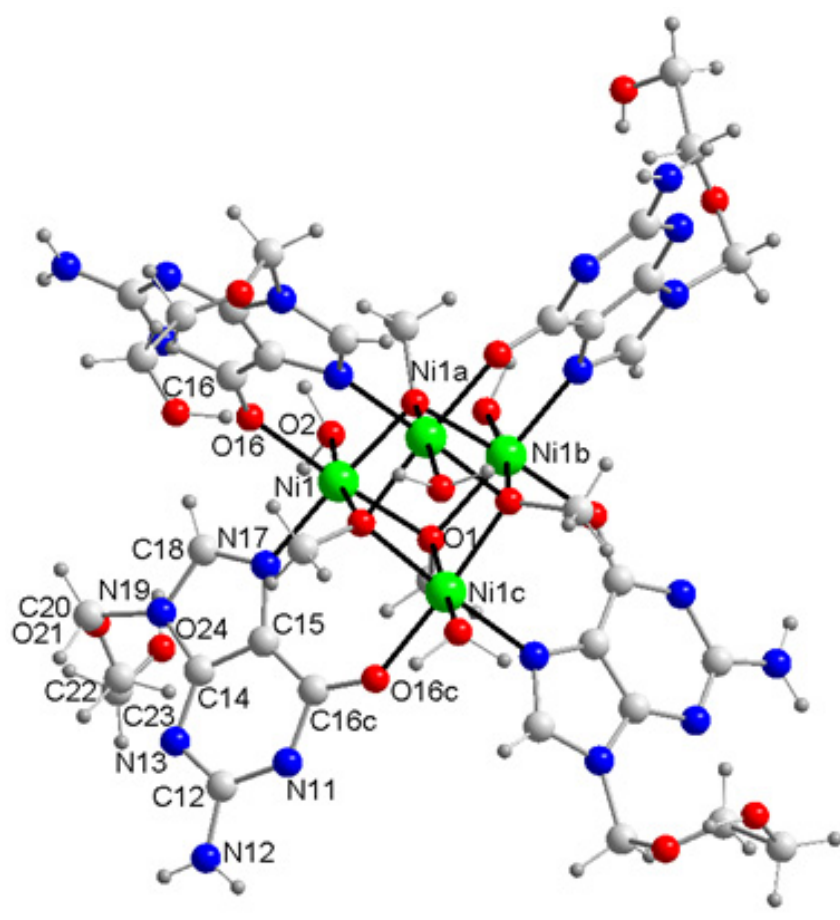
Figure 2. The tetranuclear Ni(II)-cubane cluster molecule of 1 . Symmetry codes: a = # 1 = − z + 1/4, − y + 3/4,x, b = #2 = − x + 1/4,y, − z + 1/4, c = #3 = z, − y + 3/4, − x + 1/4. Table 2. Coordination bond lengths and other relevant inter-atomic distances (Å) and trans- coordination angles ( ◦ ) in the crystal of compound 1 , [Ni(acv-H)(MeO)] 4 · 8H 2 O. See also Figures 1 and 2 for the numbering of non-H